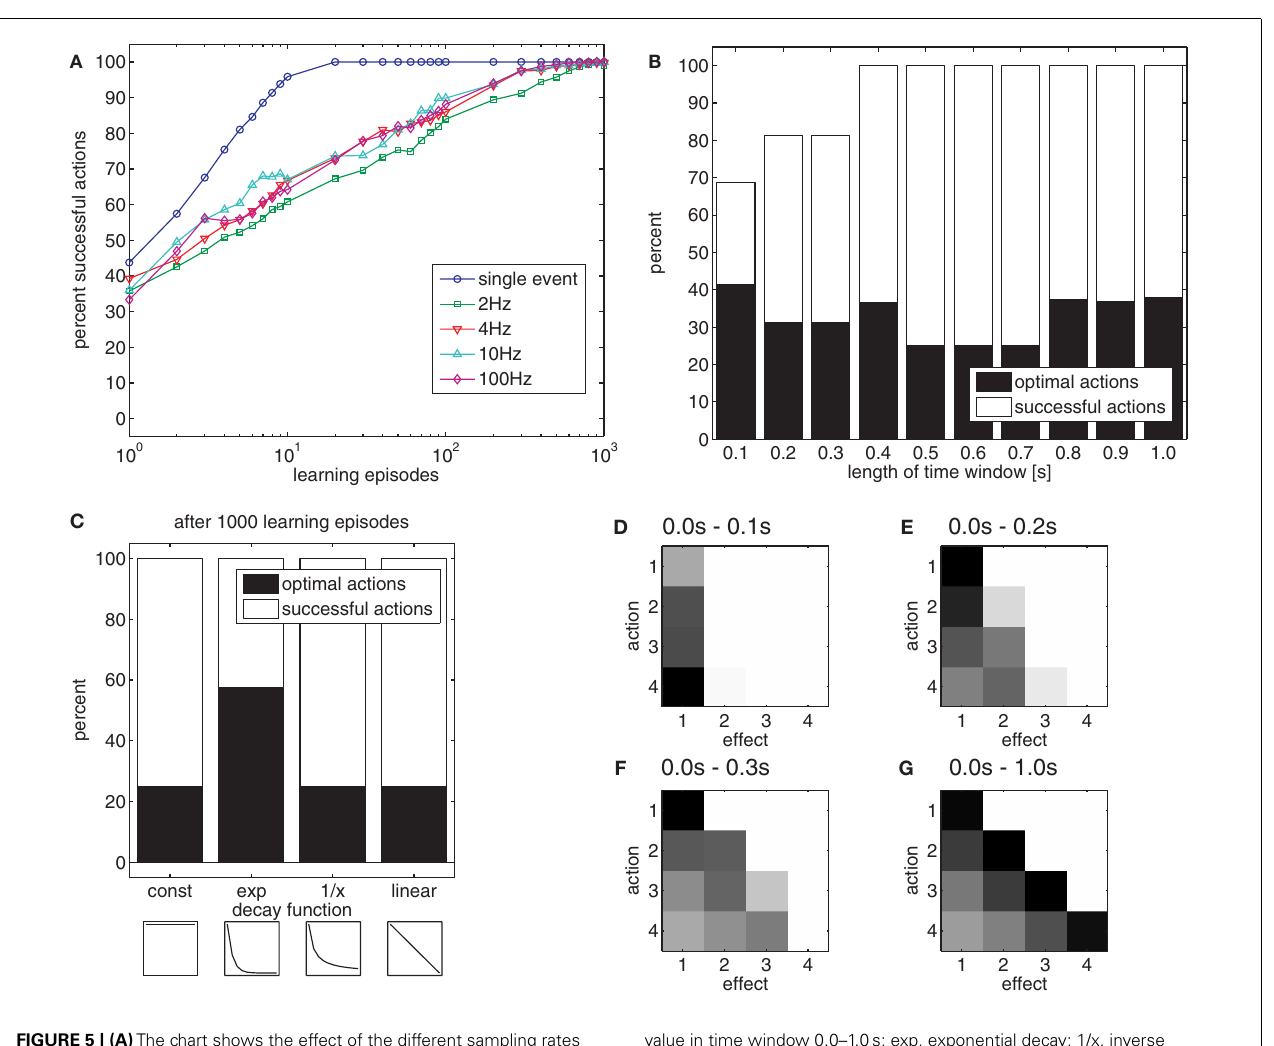
FIGURE 5 | (A) The chart shows the effect of the different sampling rates on learning if effects unfold dynamically in time. (B) The chart shows the effect of time windows of different length on the acquisition of an effective (white) and optimal (black) action-effect mapping. (C) The chart shows the effect of different trace decay functions.The insets show the decay functions between 0.0 and 1.0s after action execution: const: constant